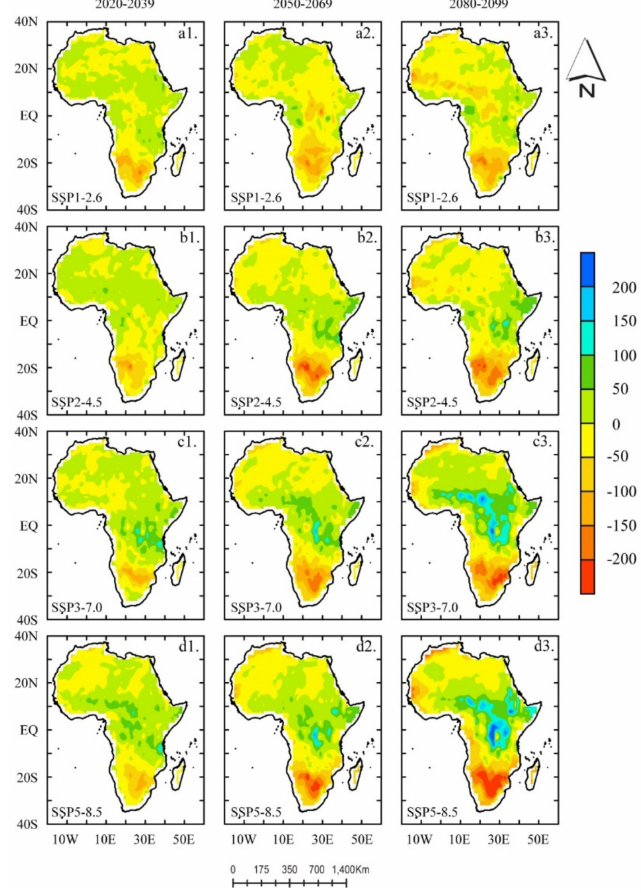
Figure 5. Spatial distribution of multi-year mean ET based on the historical mean (1995–2014) under the SSP1-2.6 ( a1 – a3 ), 2 − 4.5 ( b1 – b3 ), 3 − 7.0 ( c1 – c3 ), and 5 − 8.5 ( d1 – d3 ) scenarios in three future periods (2020–2039; 2020–2069; and 2080–2099). A positive (negative) ET value denotes a projected increase (decrease). The unit is mm year − 1